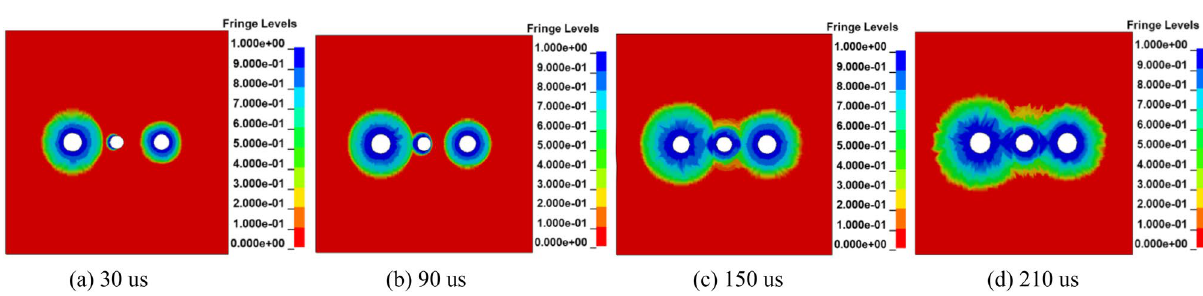
Figure 5. Damage evolution cloud map of coal without a control hole.